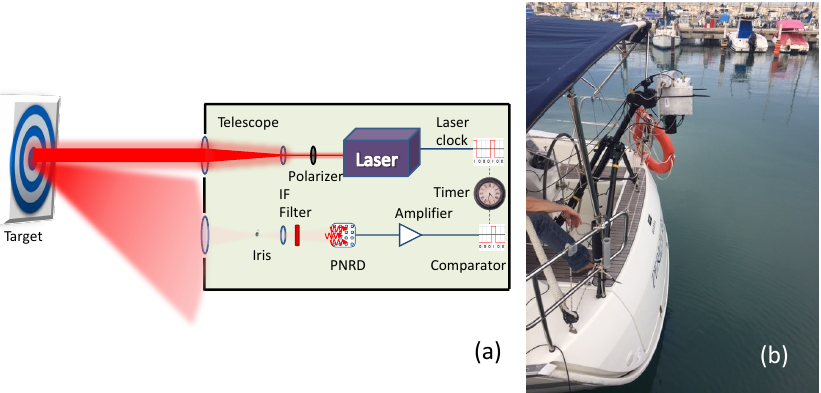
Figure 1. ( a ) Illustration of the rangefinder system. The transmission channel contains a beam expander (telescope) and a polarizer as detailed in Section 2. The receiving channel focuses the returning light onto the detector and uses a narrow filter to reduce background radiation (see also Ref. [6]). ( b ) The rangefinder, attached at the stern of the boat. Neither the boat nor the rangefinder used a stabilization protocol which reflects on the robustness of the device. The system is controlled by a laptop and data are acquired via a compact USB data acquisition